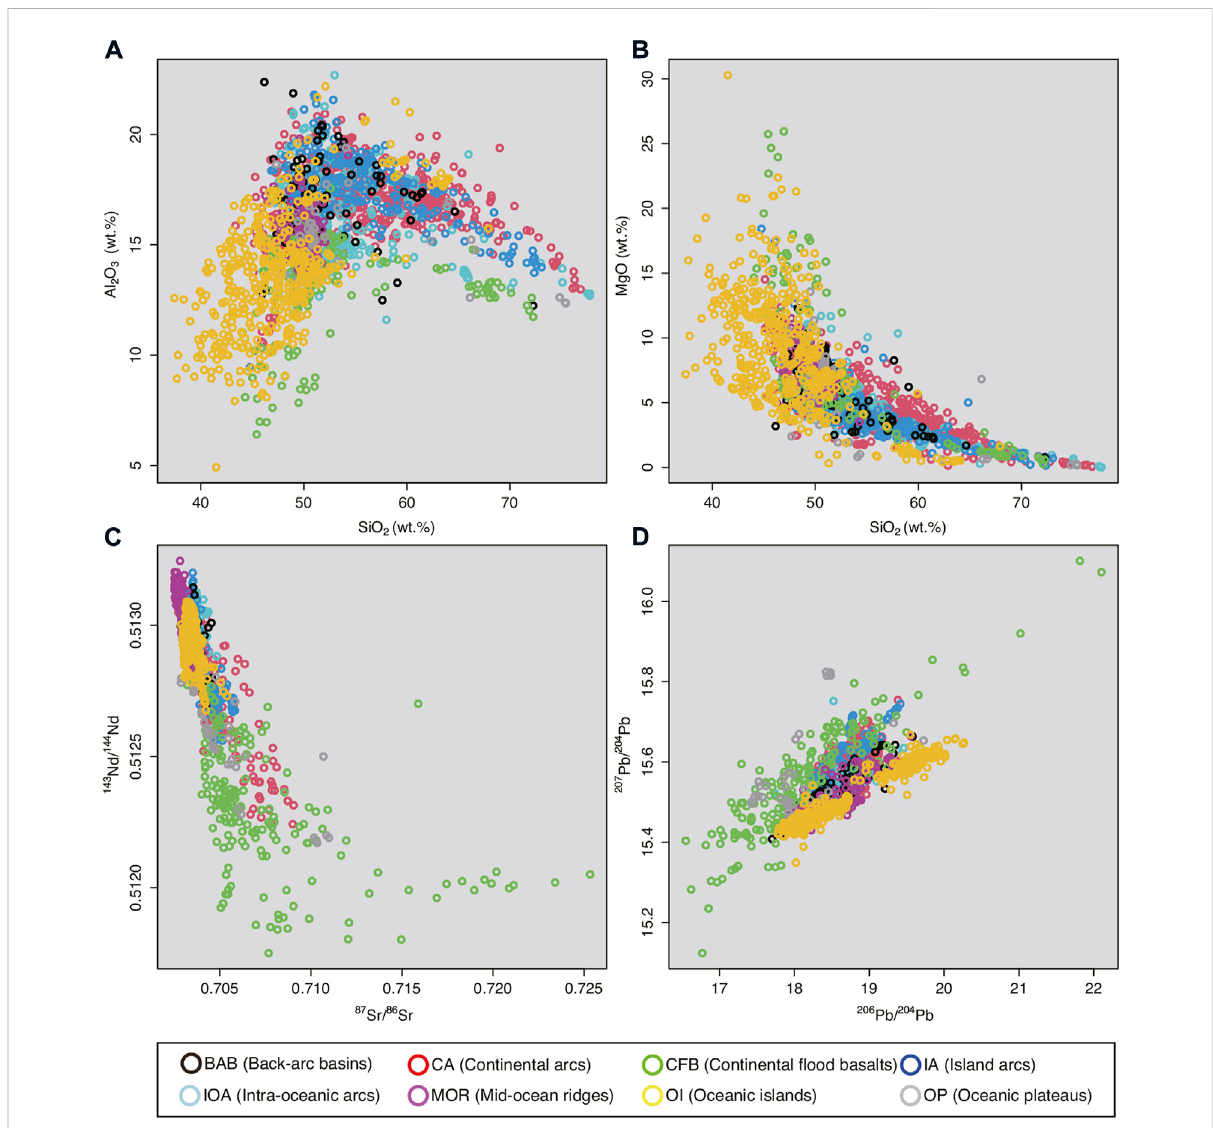
FIGURE 2 Variations in elemental concentrations and isotope ratios within the dataset used in this study. (A) SiO 2 versus Al 2 O 3 , (B) SiO 2 versus MgO, (C) 87 Sr/ 86 Sr versus 143 Nd/ 144 Nd, and (D) 206 Pb/ 204 Pb versus 207 Pb/ 204 Pb. The tectonic setting is indicated by the color of the